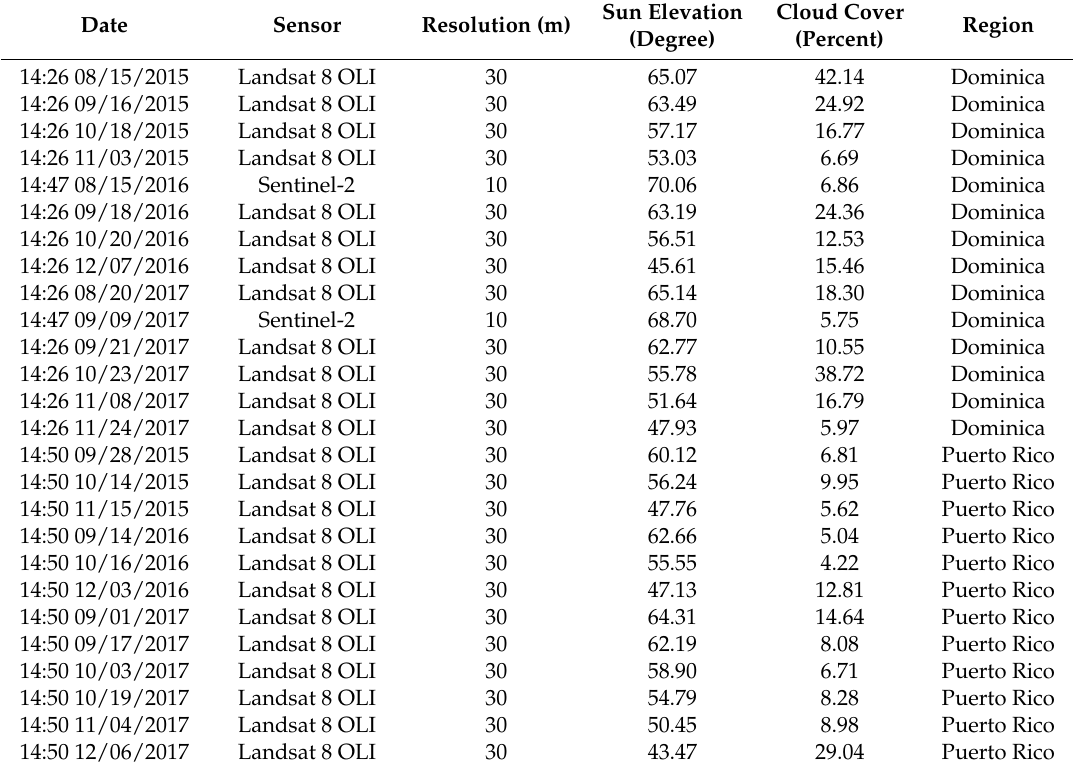
Table 2. Satellite imagery used in this